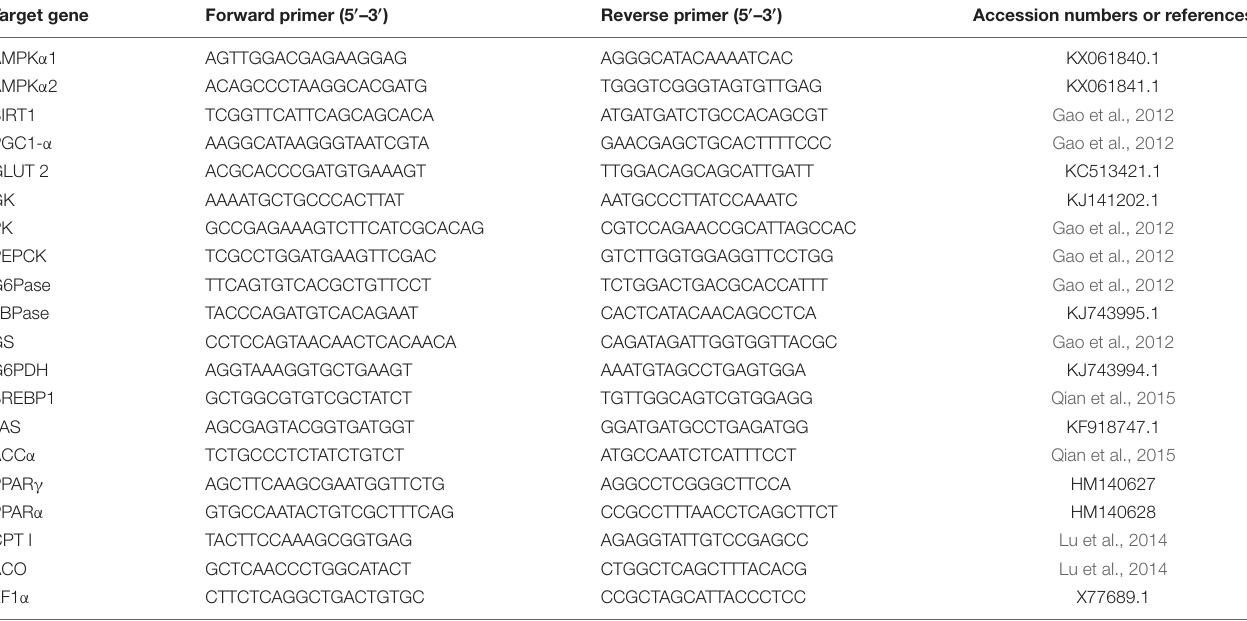
TABLE 2 | Nucleotide sequences of the primers used to assay gene expressions by real-time PCR. Target gene Forward primer (5 (cid:48) –3 (cid:48)